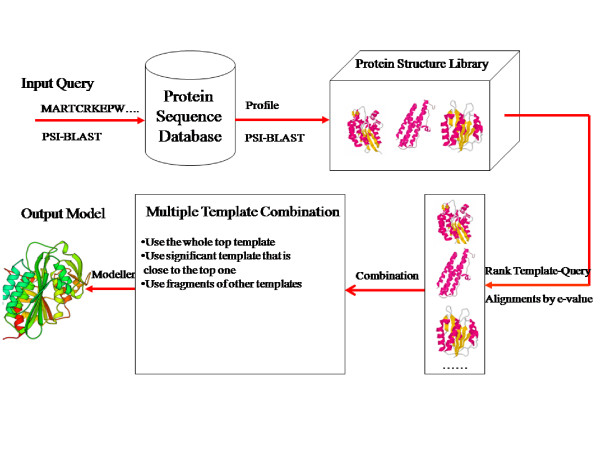
An automated multi-template comparative modeling pipeline.